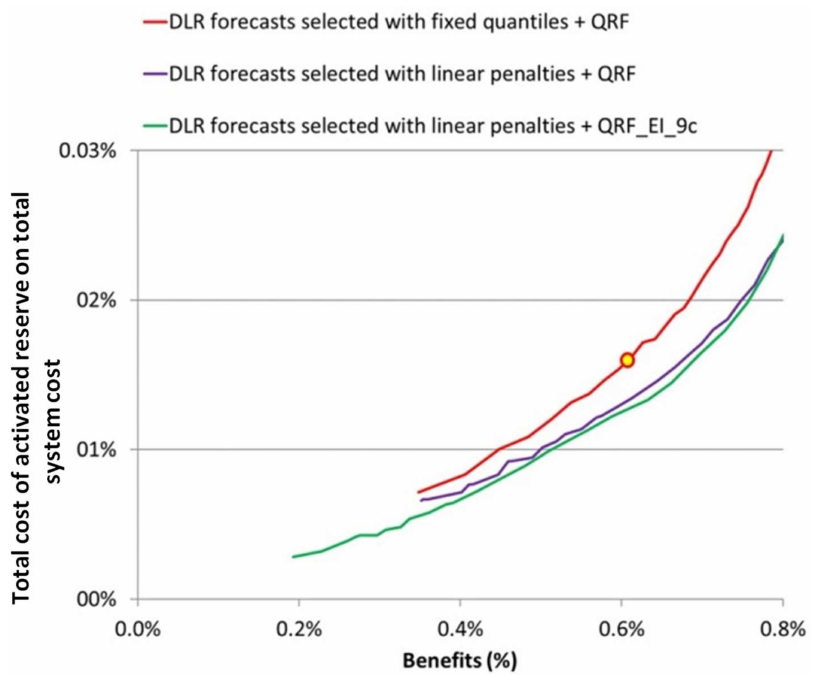
Figure 6. Evolution of the total reserve costs as a function of the observed benefits. Fixed quantiles and dynamic selection of the optimal forecasts are used. The situations associated with the use of 1% quantile forecasts are represented by a